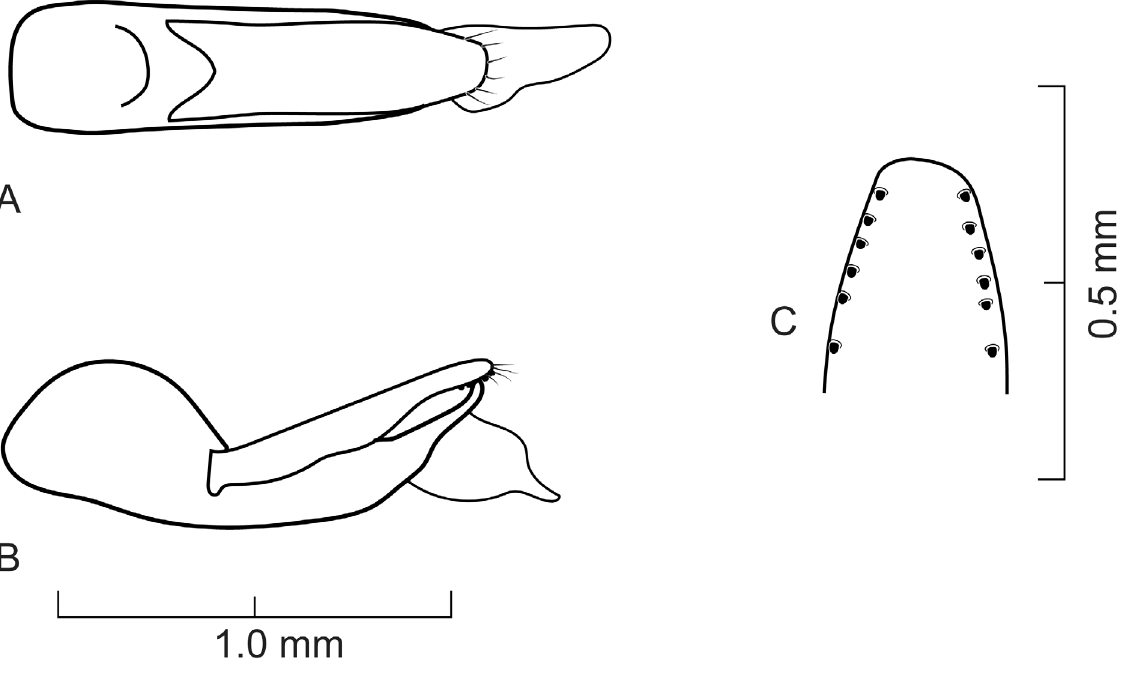
Fig. 5. Aedeagus of Ikaros polygonos gen. et sp. nov. A . Dorsal view. B . Lateral view. C . Detail of paramere, ventral